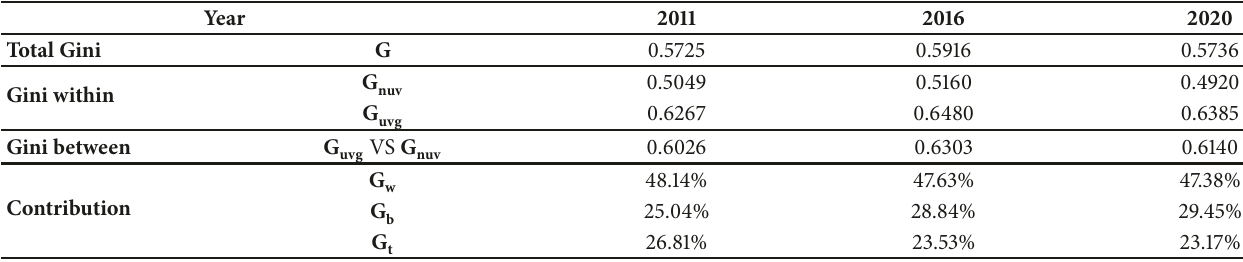
Table 5: Decomposition of the Gini coefficient between UVG and